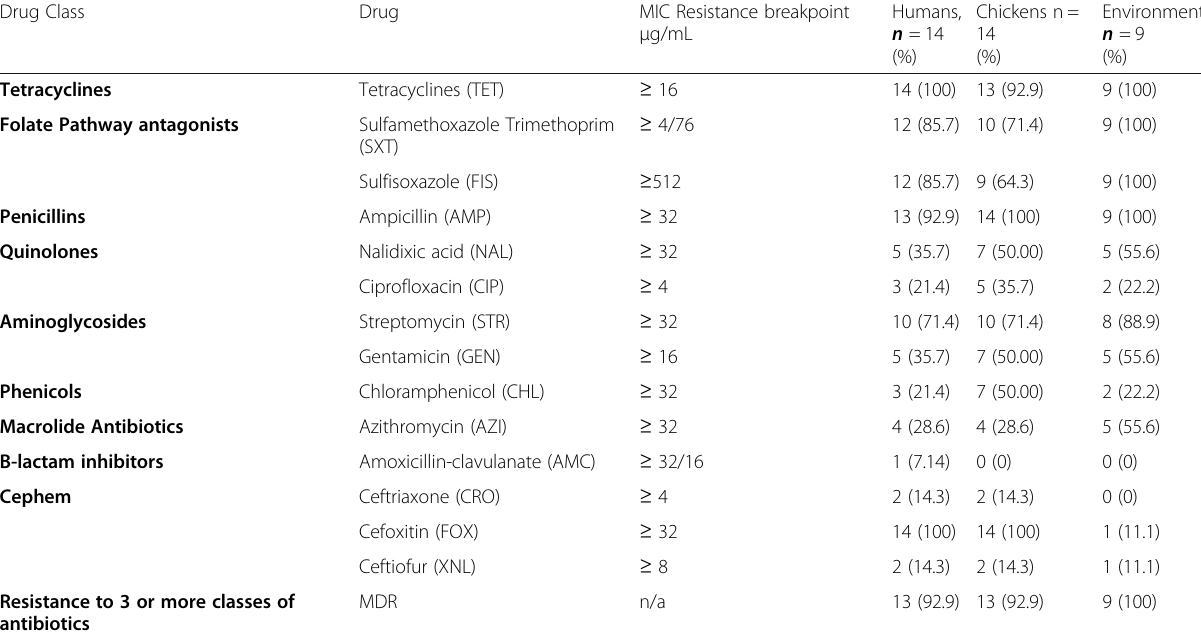
Table 1 Antimicrobial resistance profiles of ESBL-EC isolates from Humans, chickens and farm/market environments in Abuja - Nigeria, 2019